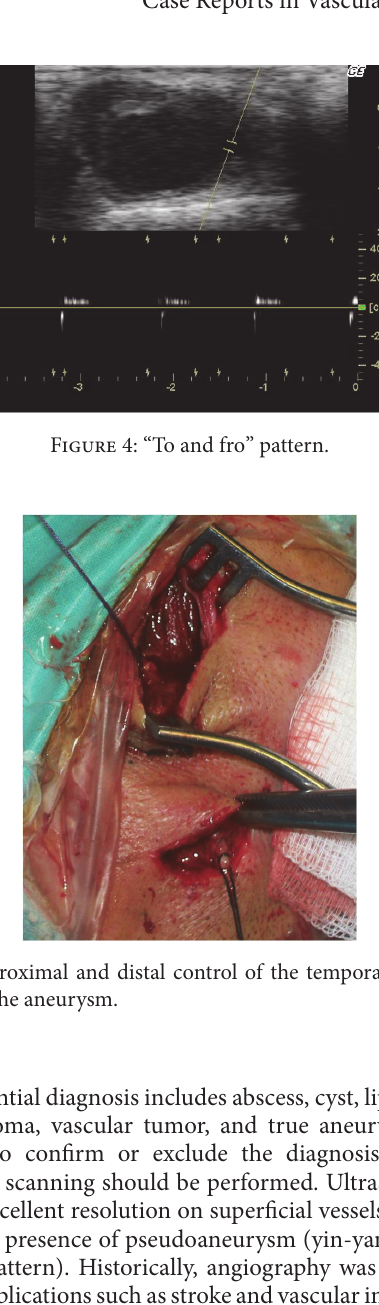
Figure 3: Ying and Yang sing.